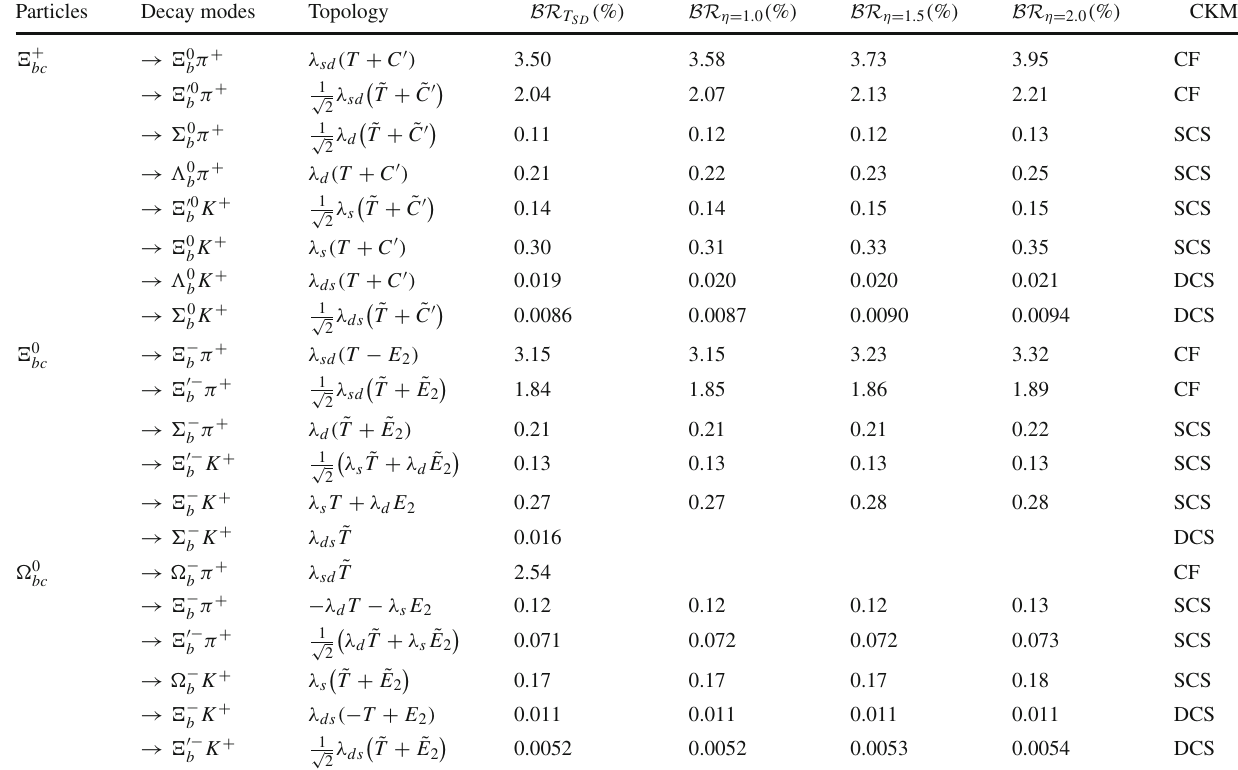
Table 2 Branching ratios for the short-distance dominated modes. The “CF”, “SCS” and “DCS” represent CKM favored, singly CKM suppressed and doubly CKM suppressed processes, respectively Particles Decay